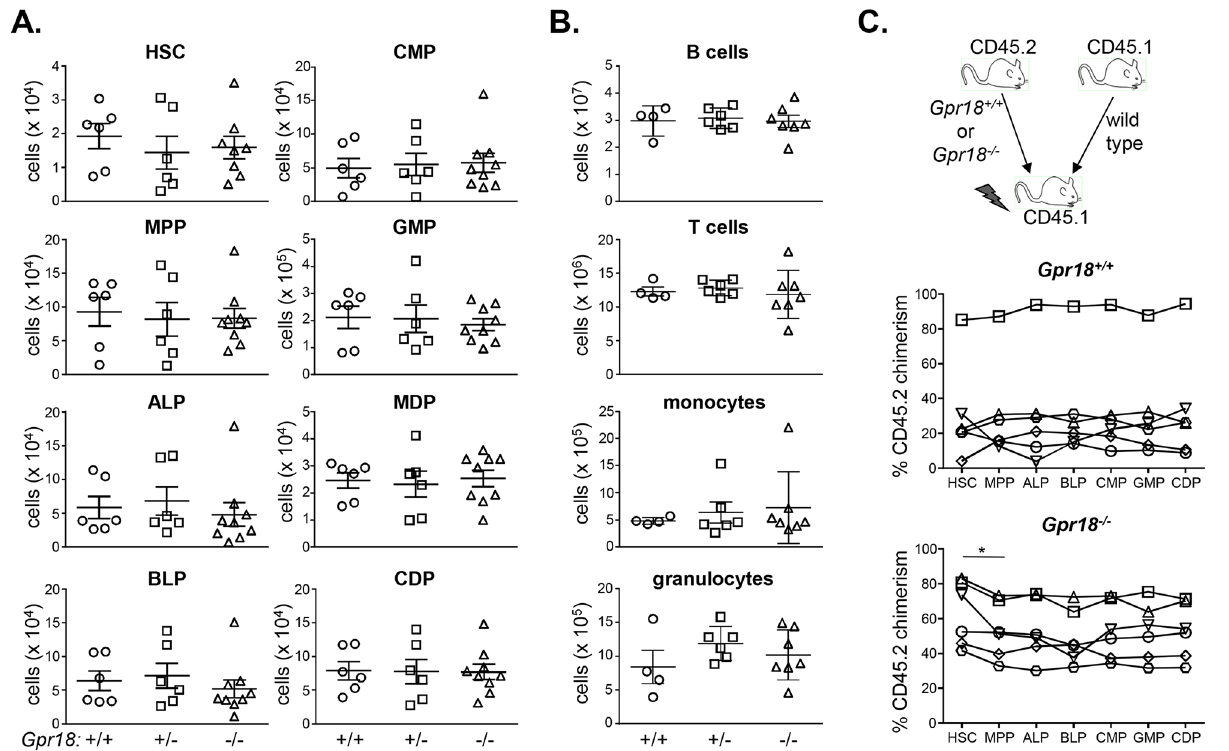
Fig 7. GPR18 is not required for lymphopoiesis or myelopoiesis. (A) Hematopoietic stem cell and progenitor numbers were quantified in Gpr18 +/+ , Gpr18 +/- , and Gpr18 -/- littermates. Mean values ± SEM are shown. No significant differences were observed between any genotype in any progenitor analyzed using 1-way ANOVA. Data are cumulative of 3 independent experiments. Gating strategies are shown in S2 Fig. (B) Mature splenic B and T cells, monocytes, and granulocytes were quantified in Gpr18 +/+ , Gpr18 +/- , and Gpr18 -/- mice. No significant differences were observed between any genotype in any progenitor analyzed using 1-way ANOVA. Gating strategies are shown in S3 Fig. (C) Donor chimerism analysis of bone marrow progenitors. Equal numbers of wild type CD45.1 + and Gpr18 +/+ or Gpr18 -/- CD45.2 + bone marrow cells were transplanted into 800cGy-irradiated CD45.1 + recipients. Eight weeks after reconstitution, CD45.2 + chimerism was quantified in progenitors as gated in (A) followed by analysis of CD45.1 and CD45.2 expression. Each unique symbol connected by a line represents chimerism within an individual mouse. * p < 0.05 using student's 2-tailed paired t-test. No other significant differences were observed in downstream progenitors relative to upstream MPPs. HSC, hematopoietic stem cell; MPP, multipotent progenitor; ALP, all- lymphoid progenitor; BLP, B lymphoid progenitor; CMP, common myeloid progenitor; GMP, granulocyte macrophage progenitor; MDP, monocyte dendritic cell progenitor; CDP, common dendritic cell